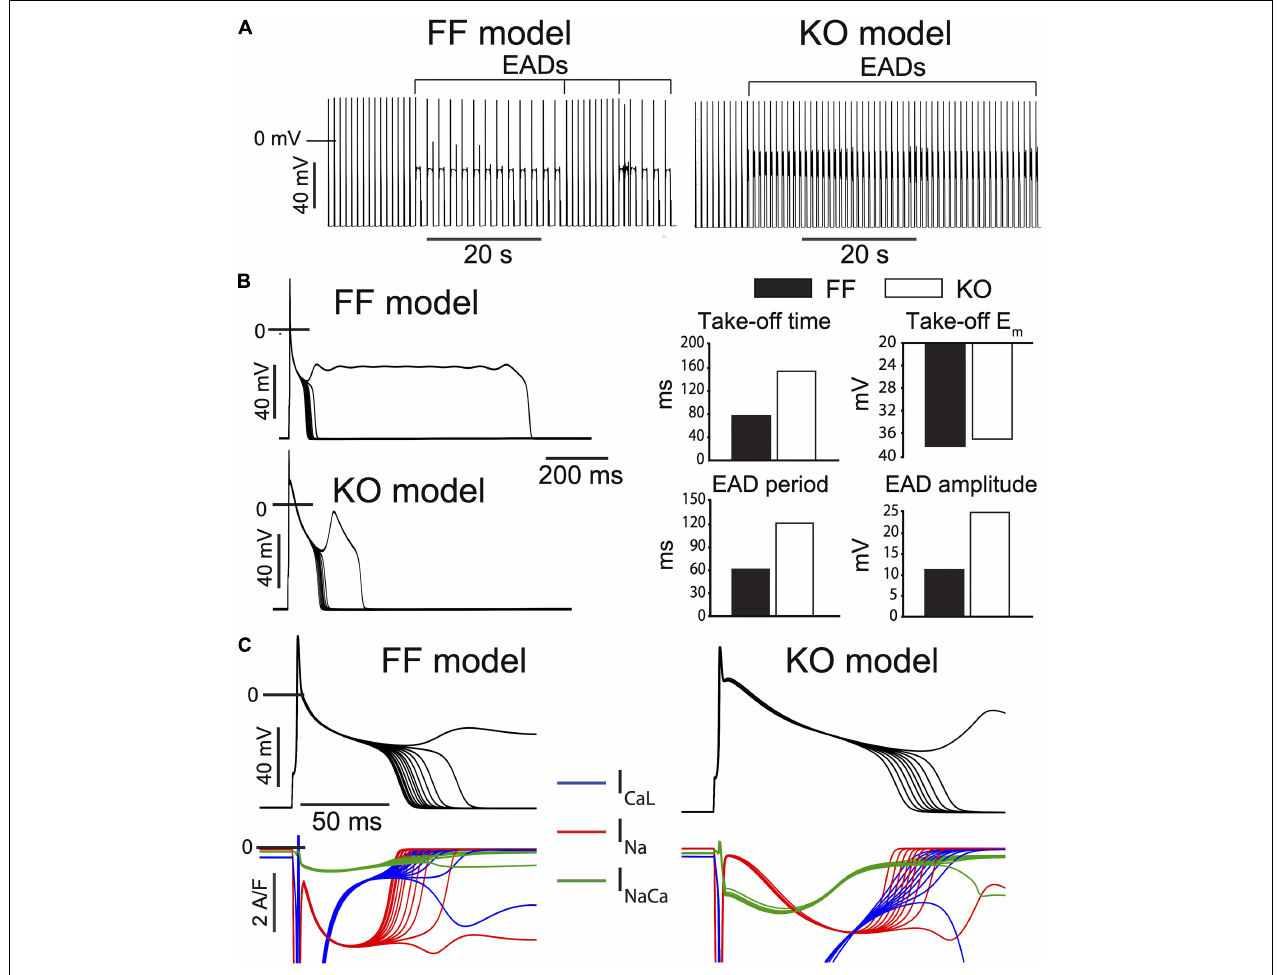
FIGURE 6 | Progressive β -adrenergic challenge was simulated in both the FF and KO models [13] and recapitulate the major differences in EAD dynamics observed experimentally. (A) Both models transition to an unstable repolarization regime involving EADs. (B) Analysis of the EAD oscillations suggest the model dynamics are similar to those observed experimentally, where EAD amplitude, period and time of initiation are all increased in KO cells, while take-off potential is only slightly more positive. (C) Somewhat surprisingly, EAD initiation and the transition into the unstable regime is driven by non-equilibrium reactivation of I Na rather than reactivation of I CaL in both models, although this dominant role for I Na is slightly more clear for the FF